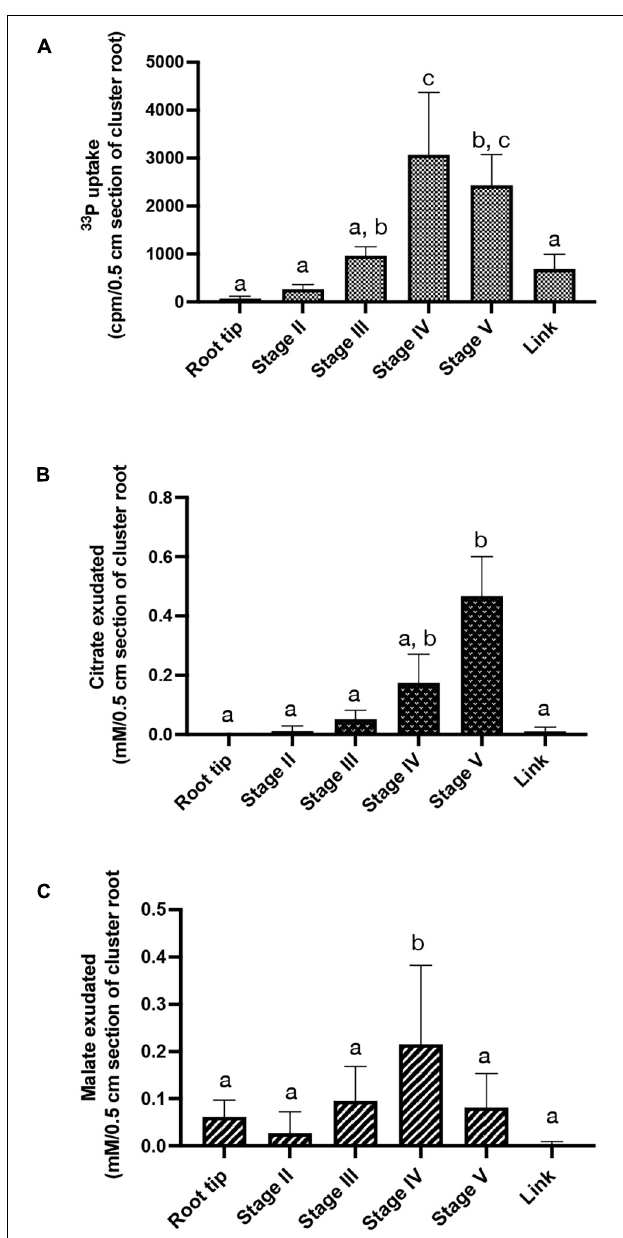
FIGURE 7 | Physiological activities along rootlet development. (A) 33 P influx in 0.5 cm cluster root sections, root tip and link segment. Values are means ± SD of three biological replicates coming each from 6 cluster roots sampled across 6 white lupin plants ( n = 3). (B) Citrate and (C) malate exudations quantified in 0.5 cm cluster root sections, root tip and link segment. Values are means ± SD of five biological replicates coming each from 6 cluster roots sampled across 6 white lupin plants ( n =